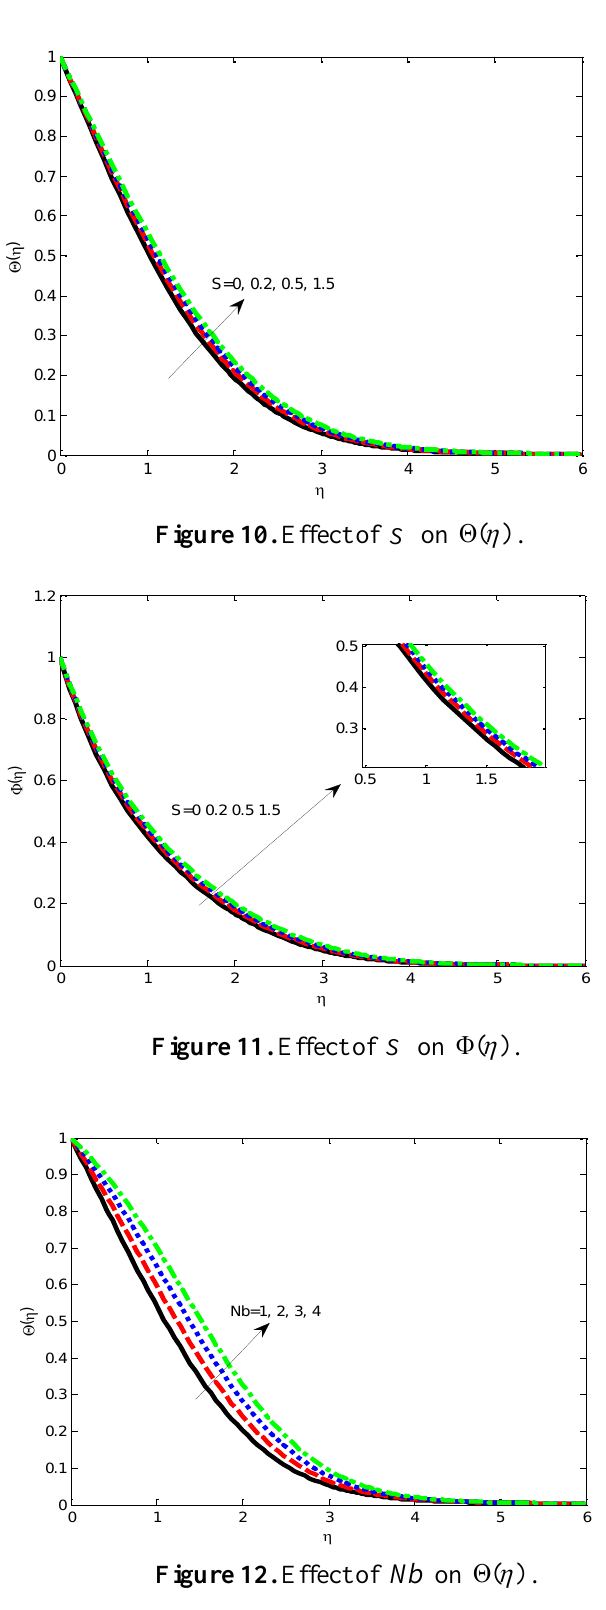
Figure 12. Effect of Nb on ( ) 